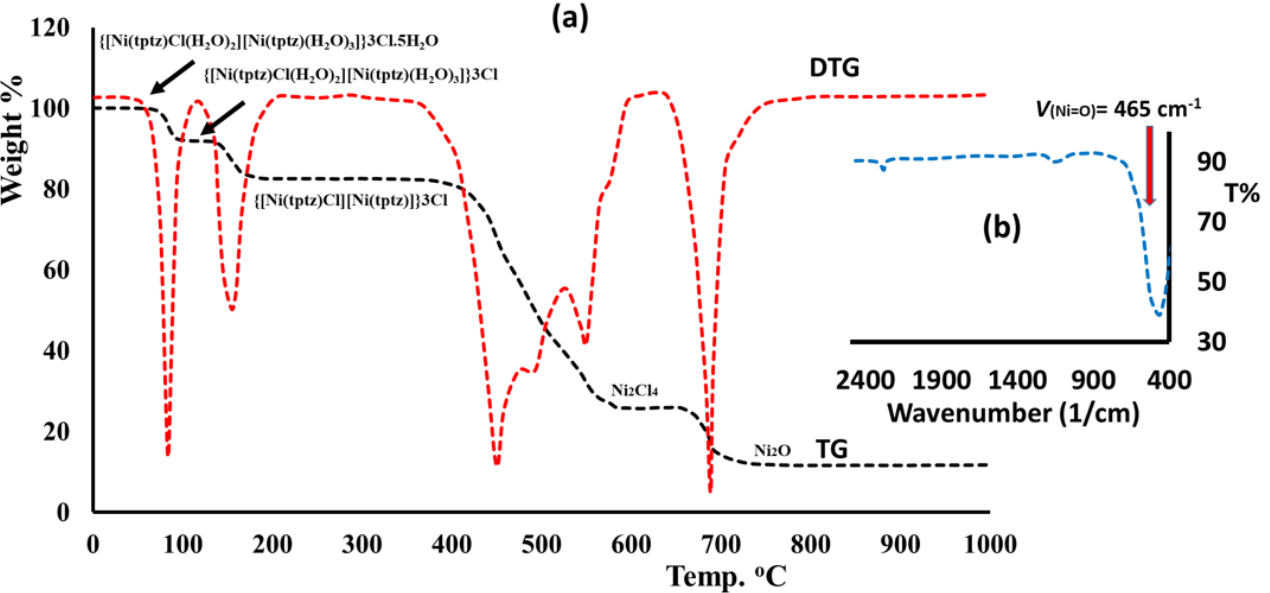
Figure 5. ( a ) TGA of the {[Ni(tptz)Cl(H 2 O) 2 ][Ni(tptz)(H 2 O) 3 ]}3Cl.5H 2 O and ( b ) Ni=O IR of the final thermal product.